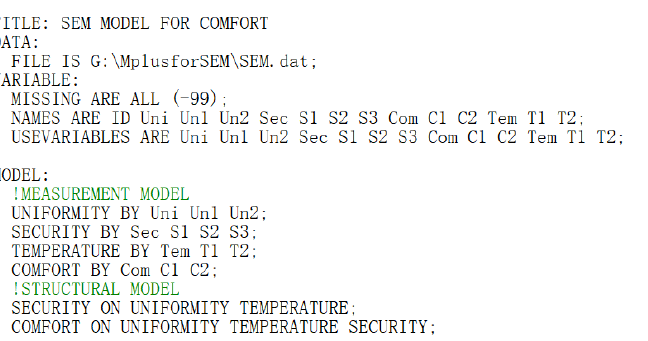
Figure 13. Construction of structural equation model in Mplus software based on the hypothetical model.